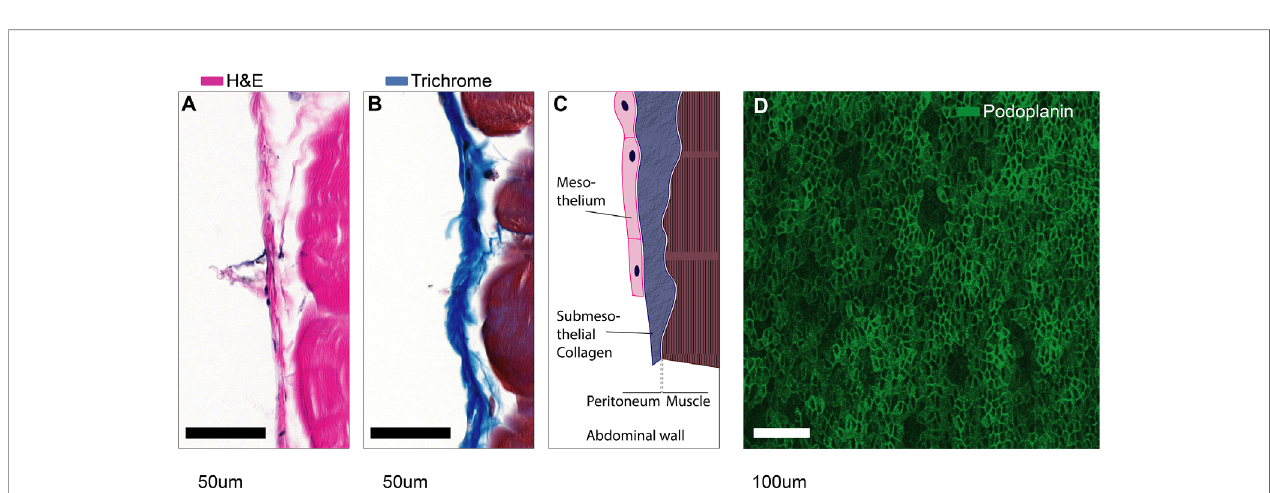
FIGURE 2 | Microanatomy of mesothelial surfaces. (A, B) Cross sections of mouse abdominal wall stained with Hematoxylin & Eosin (A) and Masson ’ s trichrome staining (B) . Scale bars: 50 µm. (C) Illustration of the structures shown in (A, B) . (D) Top view on mesothelial surface stained with anti-podoplanin